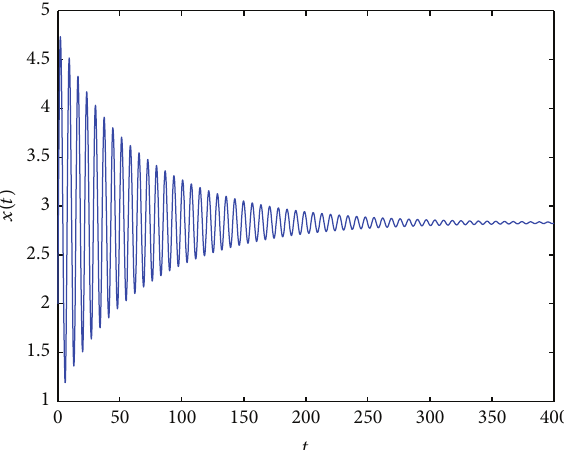
Figure 1: 𝜏 1 = 0 , 𝜏 2 = 0.68 , (𝑝 ∗ ,0) is asymptotically stable.